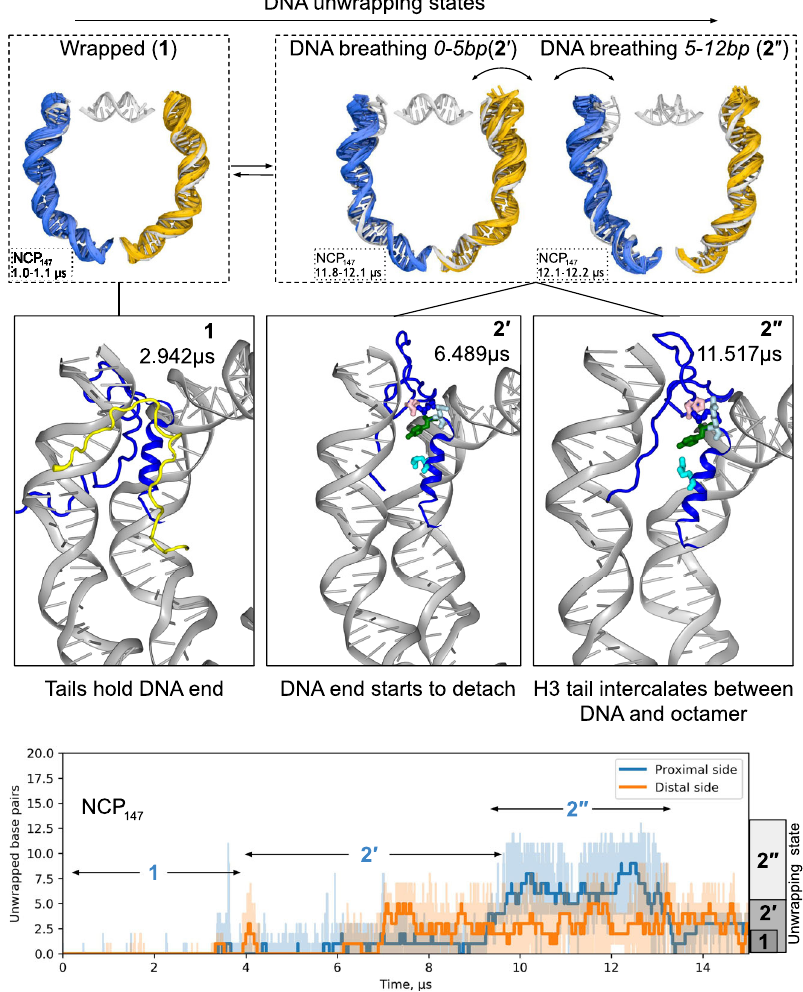
Fig. 4 Mechanisms of DNA unwrapping in nucleosomes with full-length histone tails based on NCP 147 simulation. Figure follows the design of Fig. 3. The middle panel shows typical conformations of histone tails and H3-latch residues for selected unwrapping